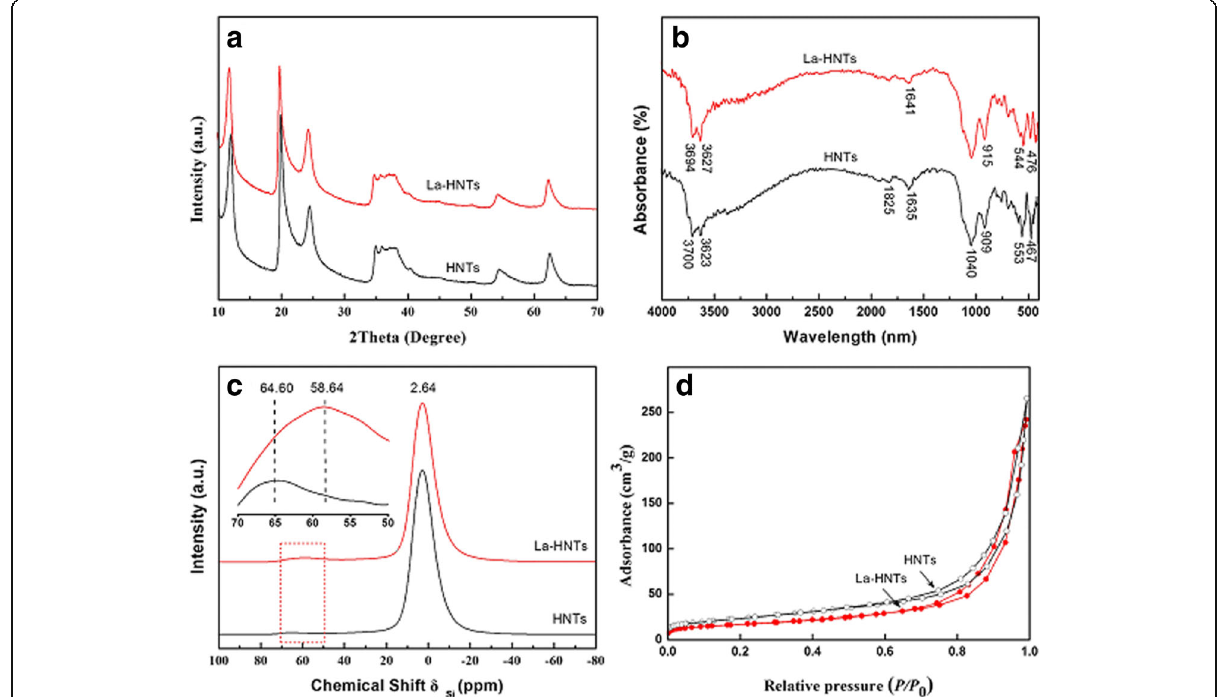
Fig. 2 a XRD patterns, b FTIR spectra, c 27 Al NMR spectra, and d nitrogen adsorption – desorption isotherms of HNT and La-HNT